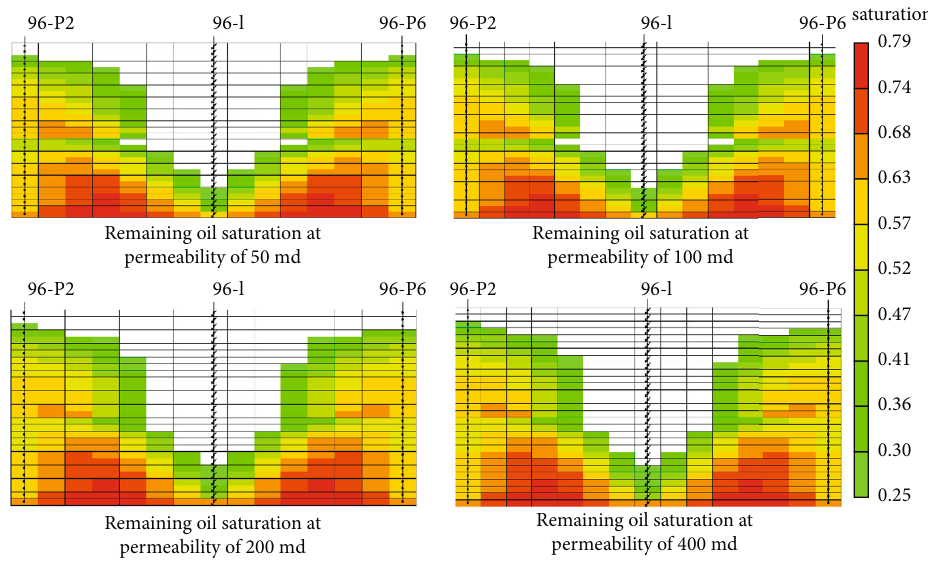
Figure 5: Remaining oil saturation pro fi les simulated under di ff erent interlayer permeabilities after steam fl ooding for 2600 days. A constant steam quality of 0.6 was used in these simulations.